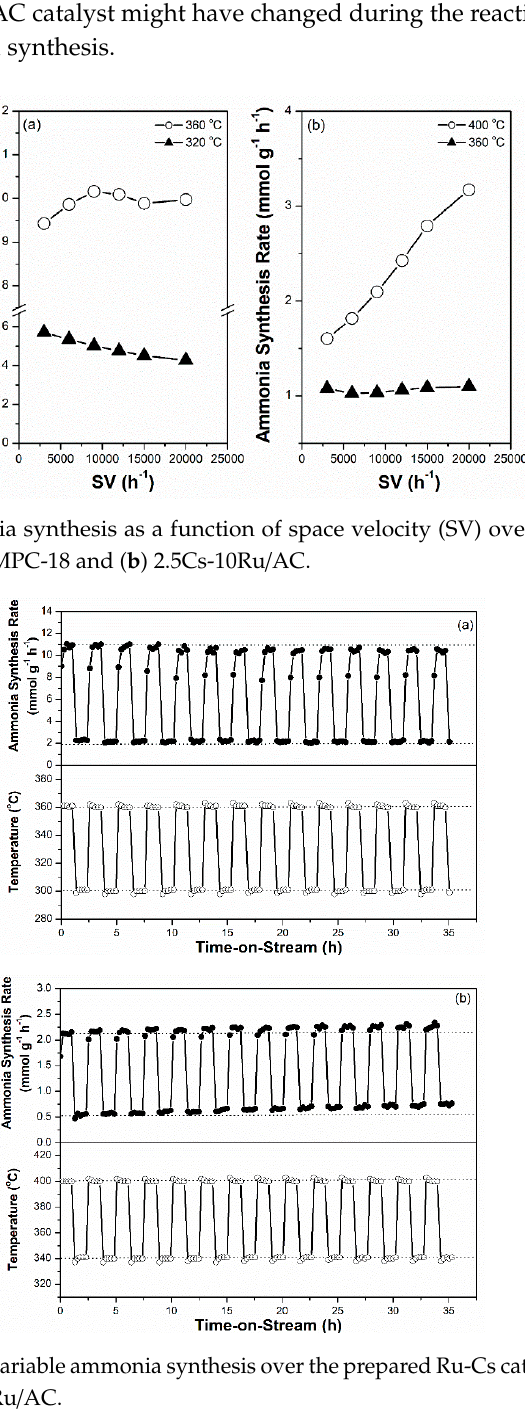
Figure 10. Intermittently variable ammonia synthesis over the prepared Ru-Cs catalysts: ( a ) 2.5Cs-10Ru/MPC-18 and ( b ) 2.5Cs-10Ru/AC.